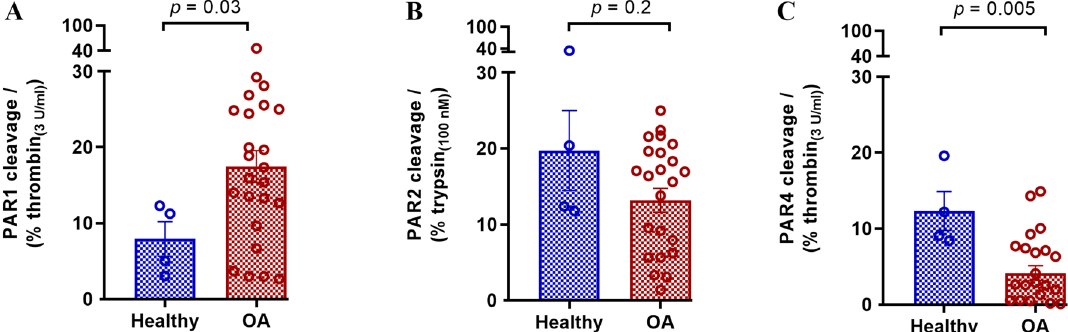
Figure 2. Cleavage of PARs by enzymes in human OA knee joint synovial fluids. Healthy and OA patient synovial fluids (10%) were applied to nLuc-hPAR-eYFP-CHO cells and release of the nLuc tag into the culture supernatants was monitored as an index of receptor N-terminus cleavage. ( A ) Cleavage of PAR1 by synovial fluids as a % of 3 U ml −1 thrombin cleavage, ( B ) Cleavage of PAR2 by synovial fluids as a % of 100 nM trypsin cleavage, and ( C ) Cleavage of PAR4 as a % of 3 U ml −1 thrombin cleavage. Histogram represents the mean cleavage ± SEM ( N = 3–5) performed in triplicate. Mann–Whitney U test was utilized to assess differences between groups. p < 0.05 was considered statistically